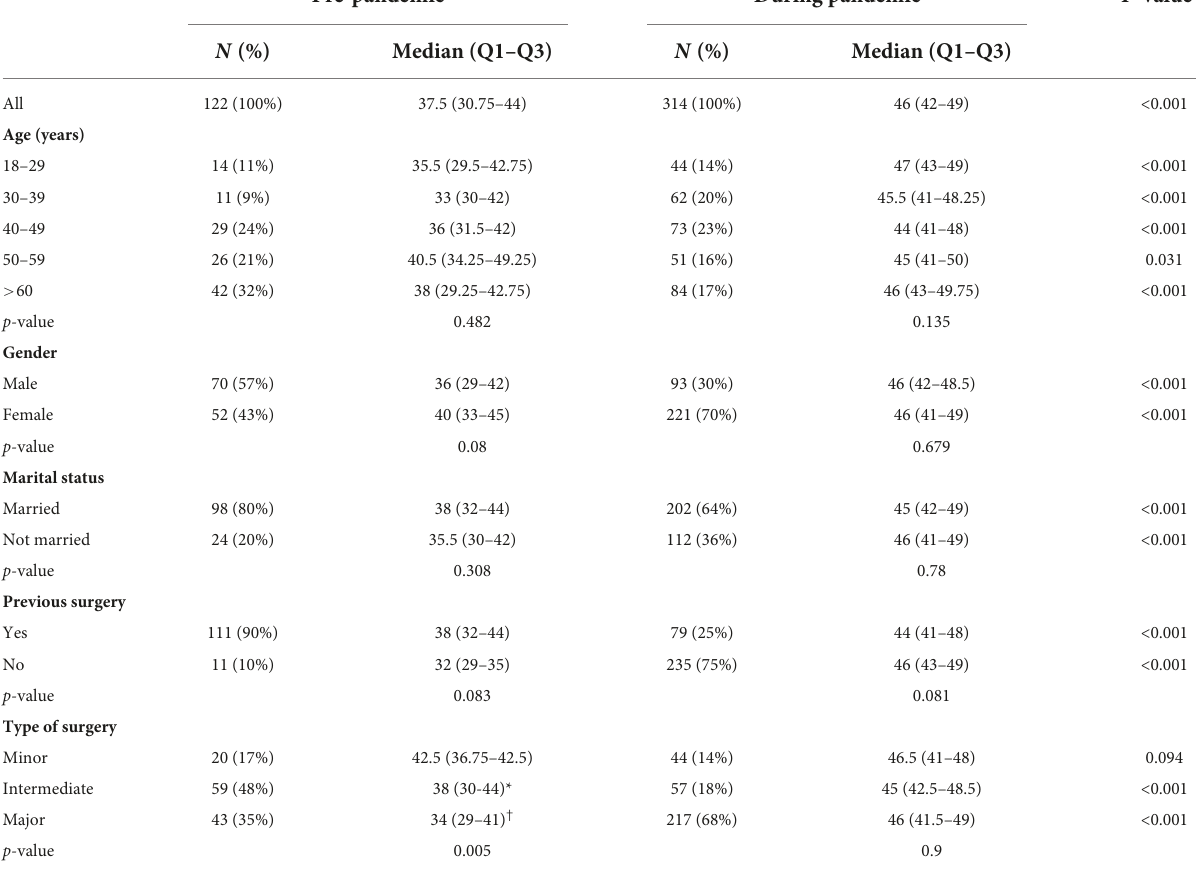
TABLE 3 STAY-Y2 score for pre-pandemic and during-pandemic groups. Pre-pandemic During